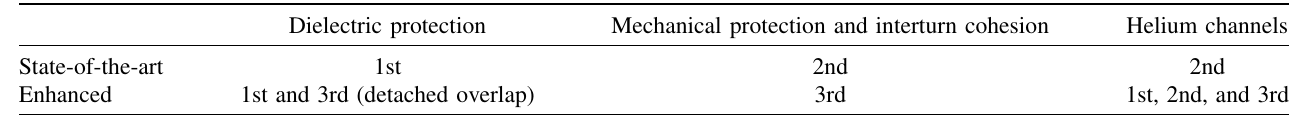
TABLE III. Specific function of each layer in LHC and enhanced insulation schemes. Dielectric